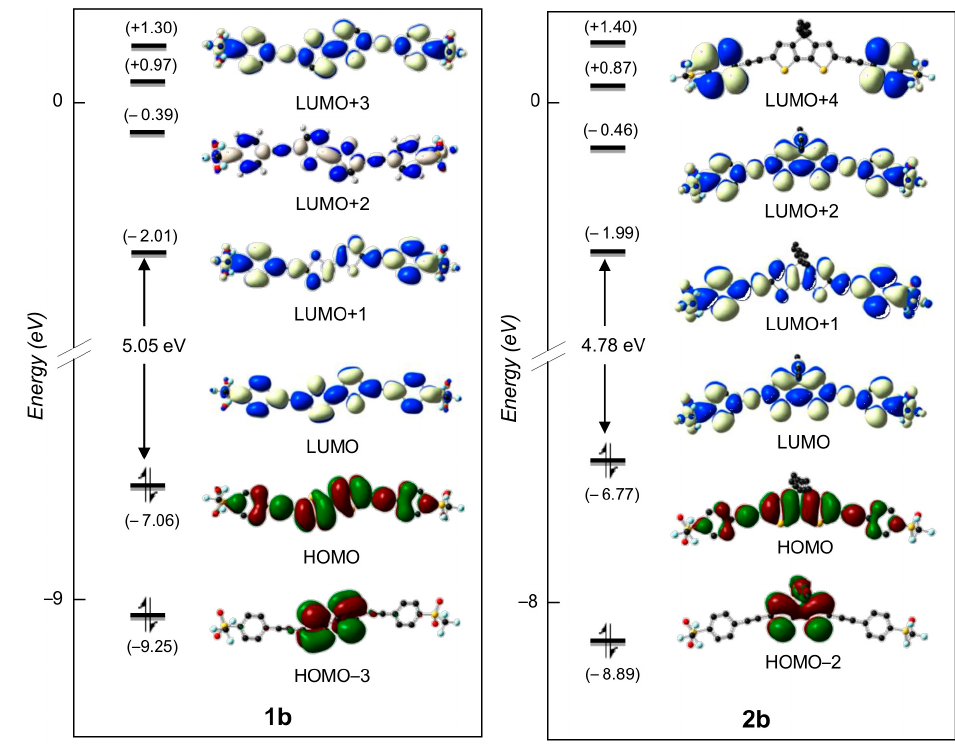
Figure 3. DFT PBE0/6-31 + G(d) optimized structures of the most stable GS conformers for molecules Figure 6. FrontierMOdiagramsof 1b ( left )and 2b ( right )(contourisodensityvalues: ± 0.015(e/bohr 3 ) 1/2 ). Figure 6. Frontier MO diagrams of 1b ( left ) and 2b ( right ) (contour isodensity values: ±0.015 1a , b and 2a , b in The hydrogen atoms are omitted for clarity. (e/bohr 3 ) 1/2 ). The hydrogen atoms are omitted for clarity.